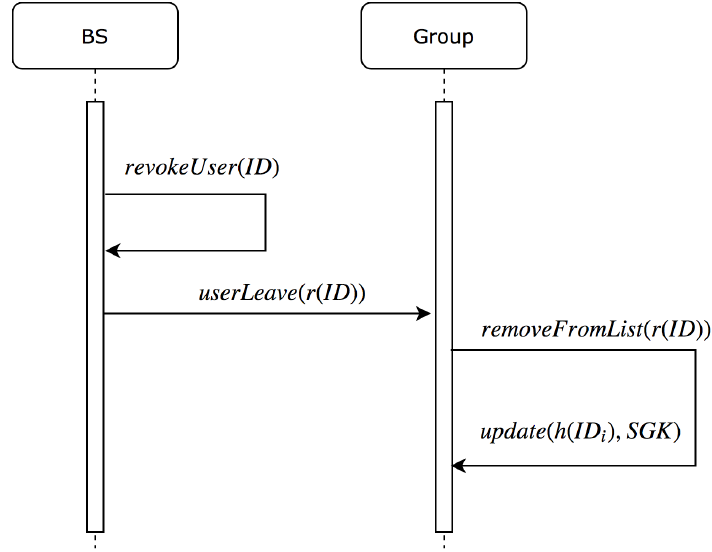
Figure 6. Sequence diagram for node identified as compromised